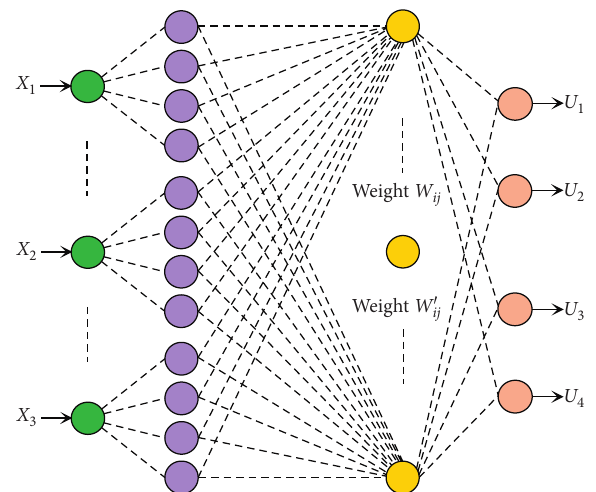
Figure 4: BP neural network model of human resource management